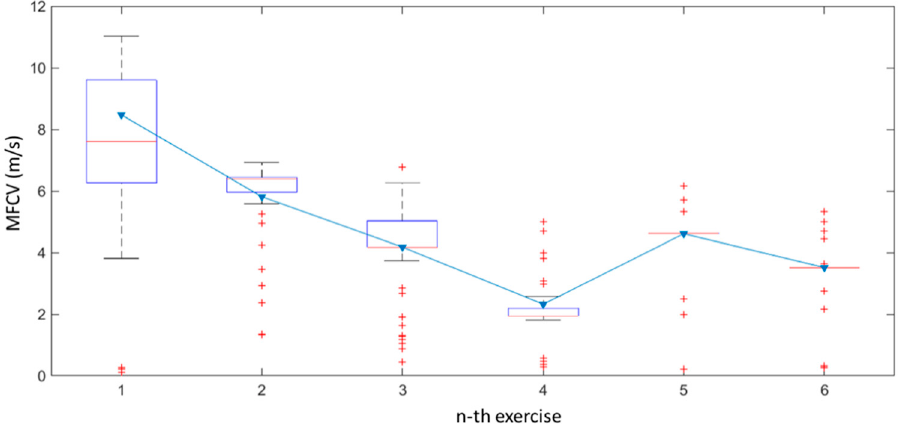
Figure 8. MFCV values behavior during squat exercise.